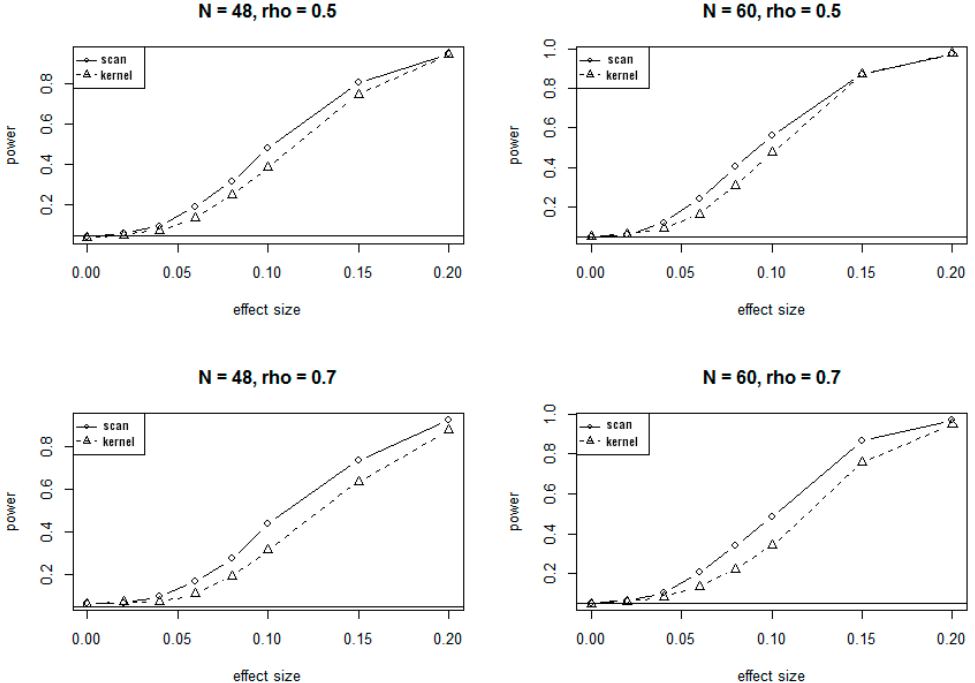
Figure 2. Power curves for SSM and KDM with 24 CpG sites at α = 0.05. rho ( ρ ) is the correlation of methylation rates between adjacent CpG sites.